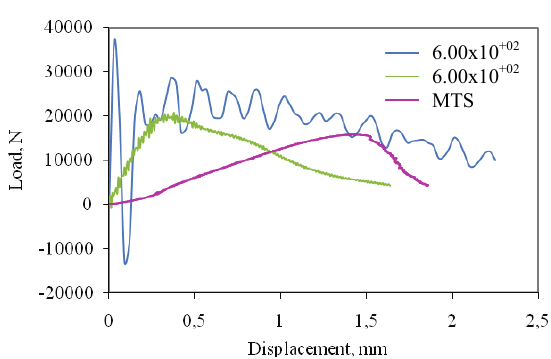
Figure 6 The load-displacement values at the different loading velocity and the comparison with the experimental data.